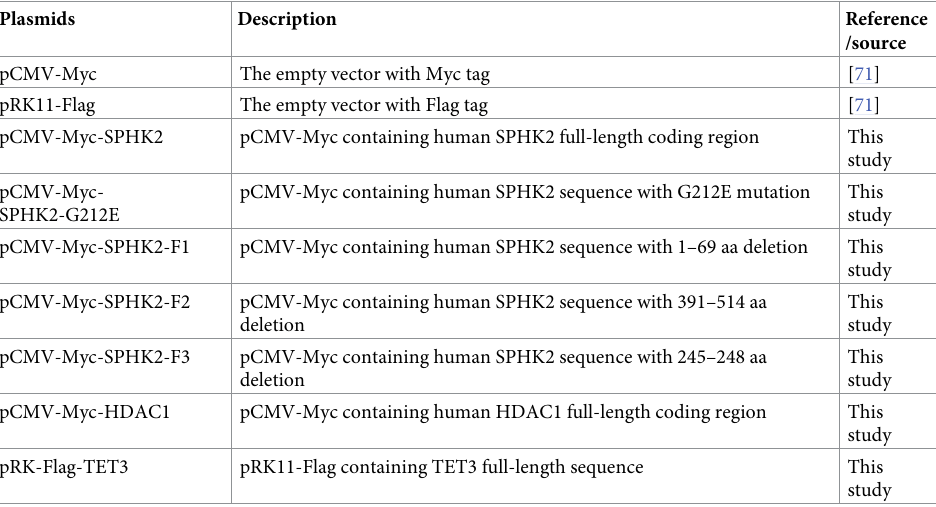
Table 1. Plasmid constructs used in the study.